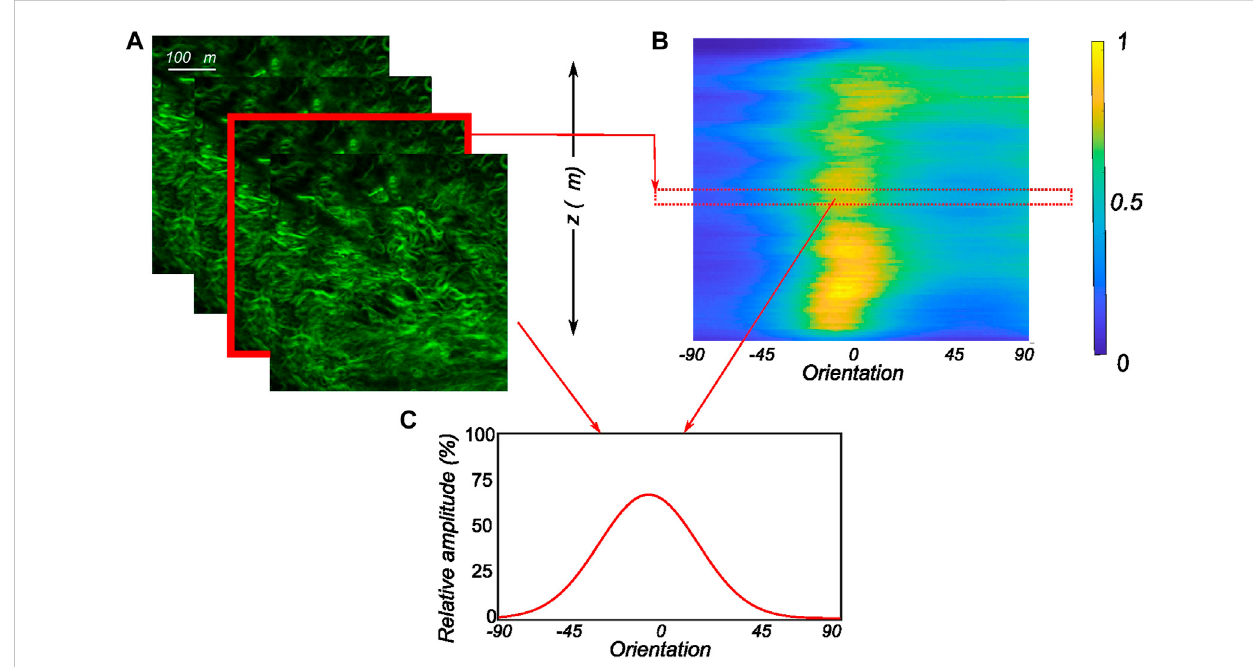
FIGURE 3 Postprocessing of the obtained MPM image stacks (A) The recorded SHG signals through the thickness of the tissue in 2 μ m intervals with each image in the stack analyzed to extract the planar orientation distribution. (B) The computed orientation distributions of all images of the MPM stack as an intensity plot with 1 representing the peak of collagen intensity and 0 representing low collagen intensity. (C) The corresponding planar orientation distribution of an individual slice of the MPM stack along with its relative position in the 3D intensity